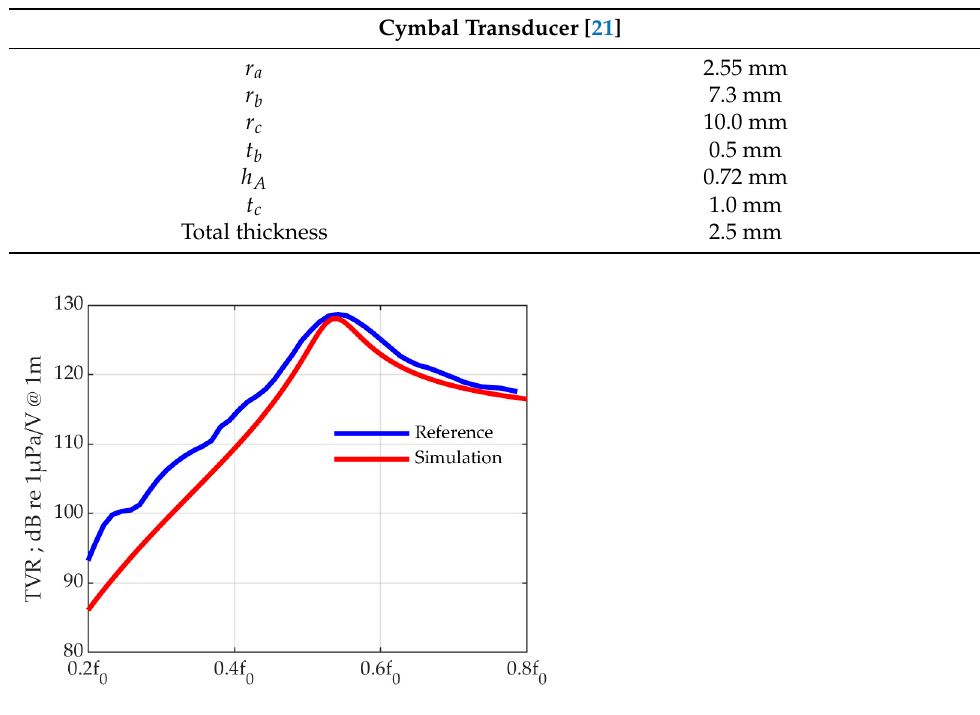
Figure 9. Comparison of the reference model for simulation verification and the finite element analysis model of this paper.